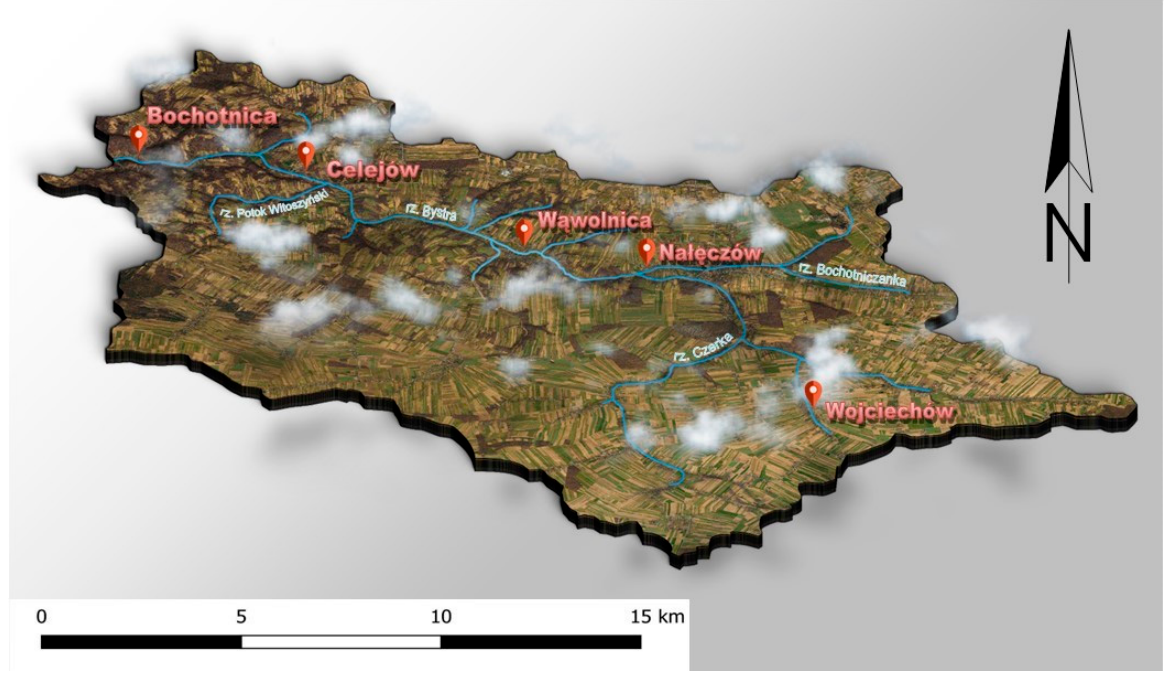
Figure 2. The catchment area of the Bystra River (own study).